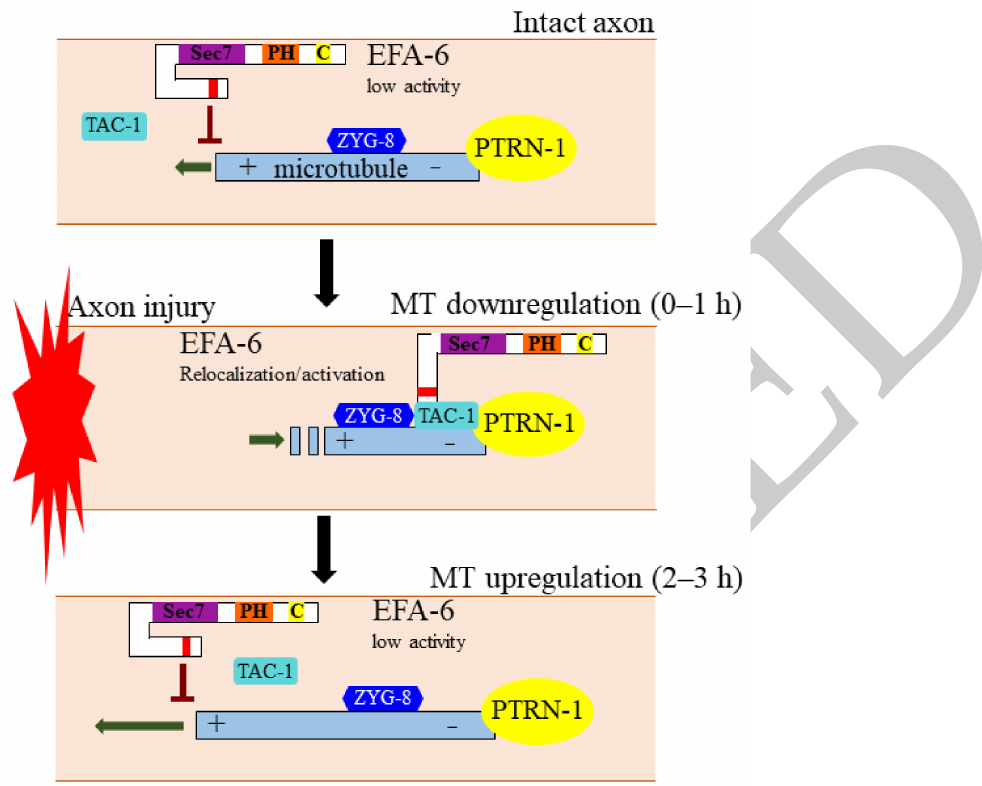
Figure 2. EFA-6 regulates axonal microtubule dynamics to inhibit axon regeneration. Axon injury of C. elegans neurons triggers a rapid relocalization of EFA-6 from the plasma membrane to struc- tures overlapping with the microtubule minus end binding protein PTRN-1. This relocalization of EFA-6 occurs simultaneously with an injury-induced local downregulation of axonal microtubule polymerization, a process that requires EFA-6. EFA-6 directly interacts with TAC-1 and ZYG-8, two conserved microtubule regulators that are required for axon regeneration. At 2–3 h post in- jury, EFA-6 protein returns back to the plasma membrane, coincident with an up-regulation of microtubule